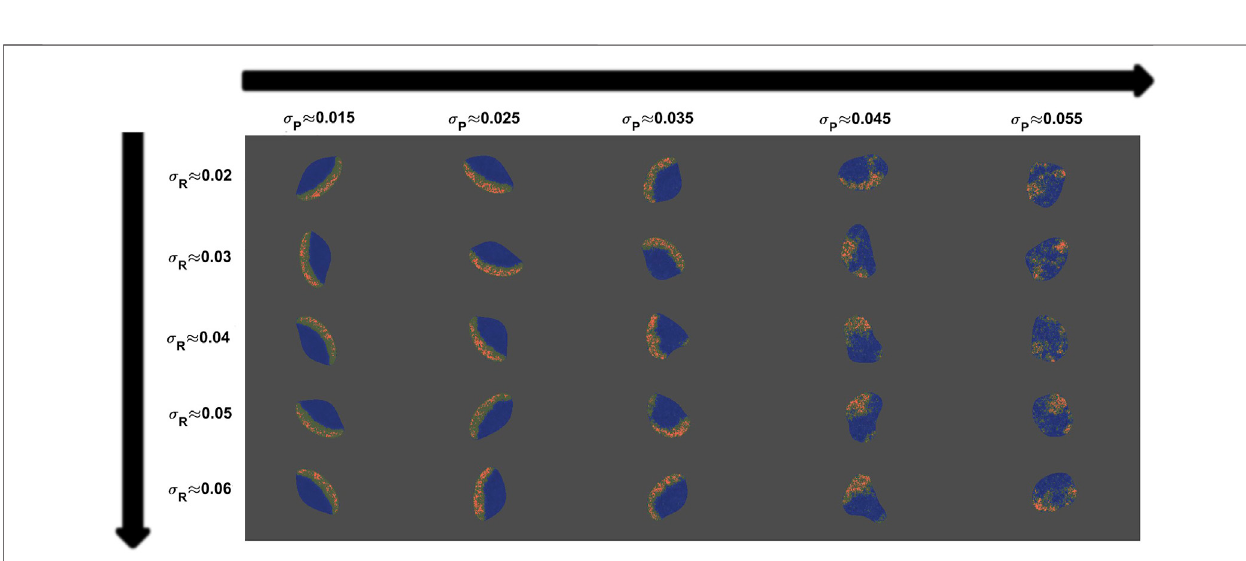
FIGURE 7 | Map of snapshots of the virtual cell taken from different variance values of noise intensity for the new mass-conserved model. For each column, snapshotsindicatePdistribution (red)insidethecell.Thevalueoftheparameterofthesimulationsare